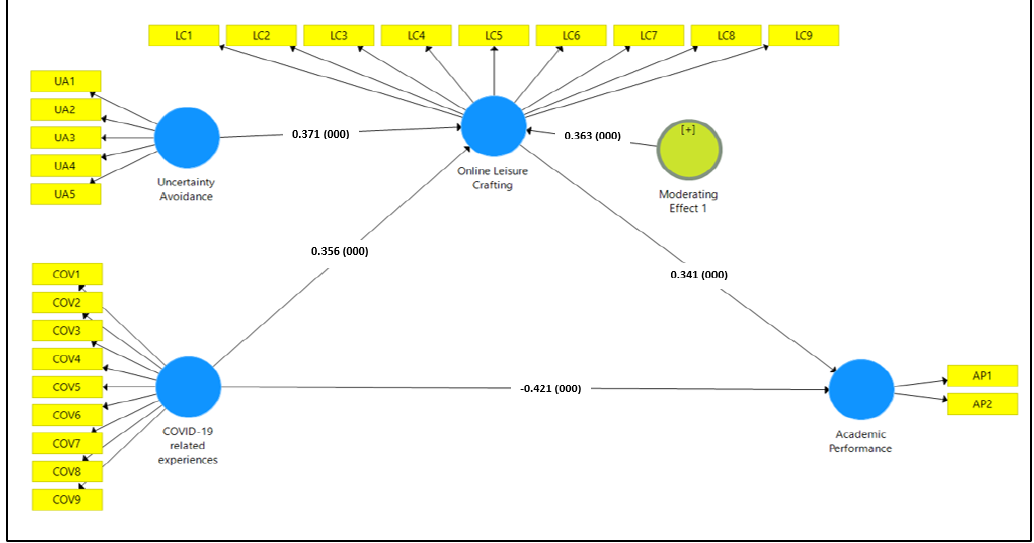
Figure.2. Research framework results